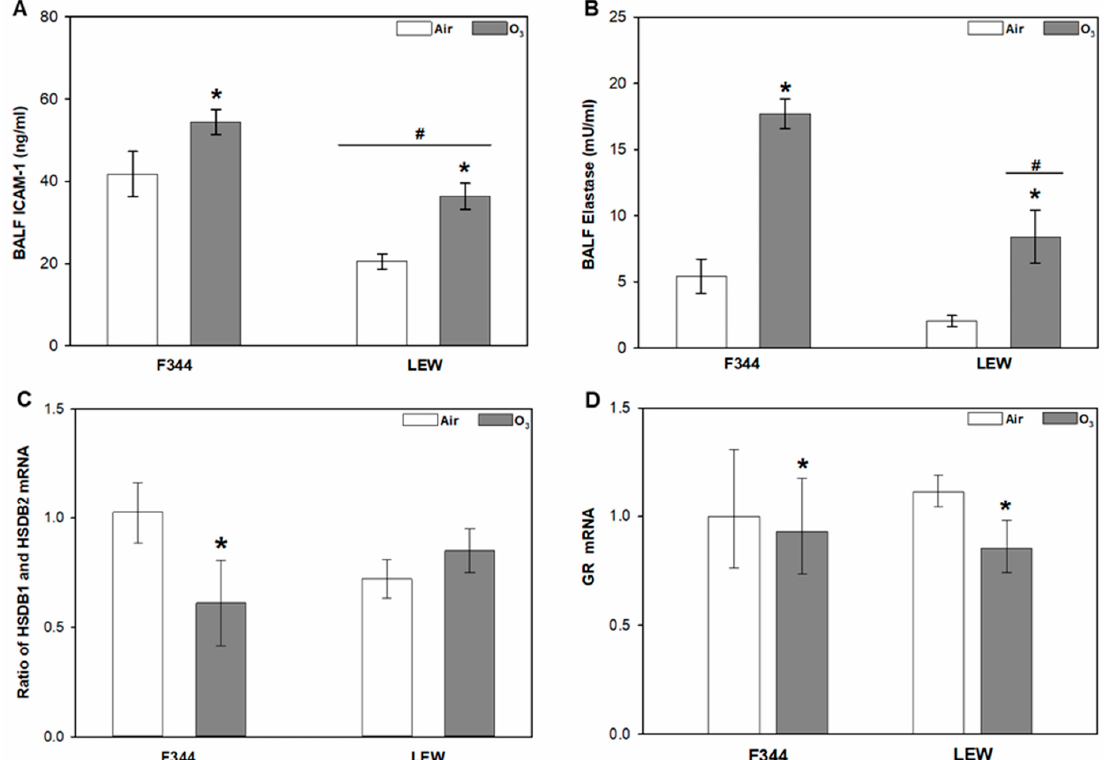
Figure 2. Glucocorticoid-regulating factors in the lungs in Fischer (F344) and Lewis (LEW) rats after exposure to air or 0.8 ppm ozone (O 3 ) for 4 h. ( A ) Protein levels in bronchoalveolar lavage fluid (BALF) of intercellular adhesion molecule-1 (ICAM-1); Ozone ( p = 0.001) and Strain ( p < 0.001) main effects. ( B ) Elastase activity in BALF; Ozone × Strain interaction, p = 0.048. ( C ) 11 β -Hydroxysteroid dehydrogenase 1 (HSDB1) and HSDB2 ratio (calculated from the mRNA abundance data); Ozone main effect, p = 0.030. ( D ) Glucocorticoid receptor (GR) mRNA levels in lung tissue; Ozone main effect, p = 0.01. * 0.8 vs. 0 ppm ozone within given strain (except for GR where an asterisk indicates the Ozone main effect across strains); # LEW vs. F344 within indicated exposure level; two-way ANOVA followed by Holm–Sidak post-hoc test; n = 4–5 rats. For ( A – C ), data are expressed as mean ± SEM and for ( D ) data are expressed as geometric mean of fold-change relative to the F344 air control ± 95% confidence intervals.